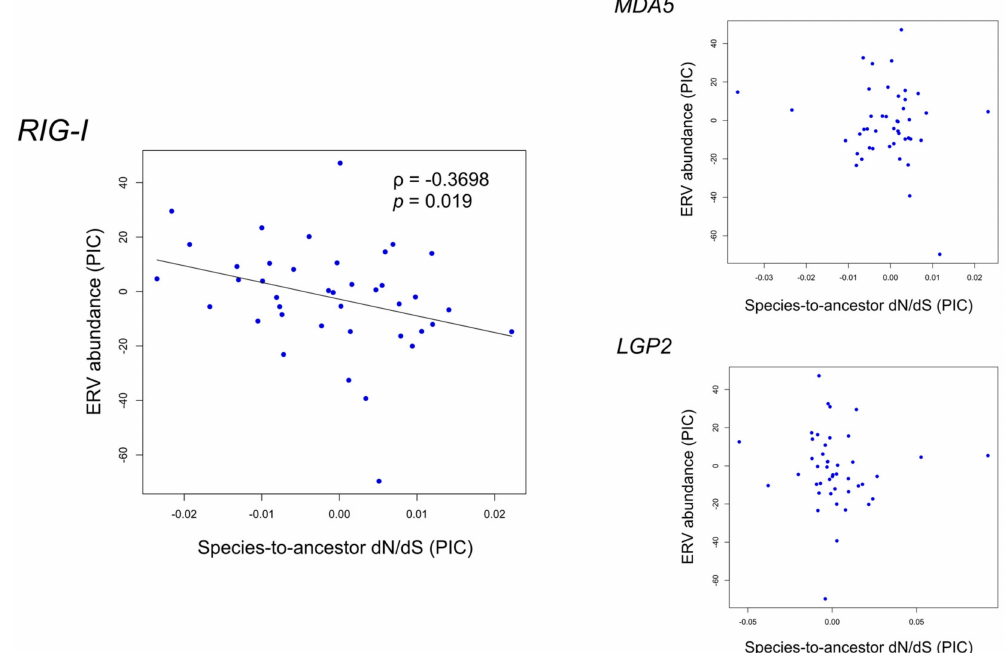
Figure 4. Relationship between the phylogenetic independent contrasts (PICs) of endogenous retroviruses (ERV) abundance and species-to-ancestor dN/dS of three avian RIG-I-like receptors. When Spearman’s correlation has a p < 0.05, a trend line is shown. Note that the slope is not equal to Spearman’s rank correlation coefficient (‘ (cid:36) ’ in the